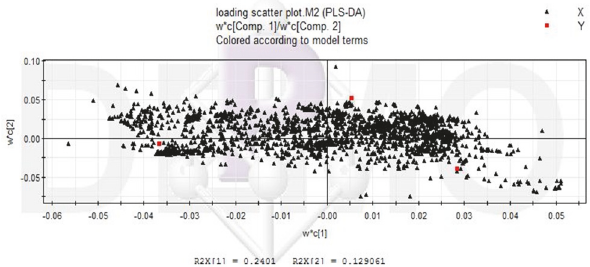
Figure6:LoadchartofPLS-DApatternintreatmentofchronicliver failure with nonbioartificial liver.